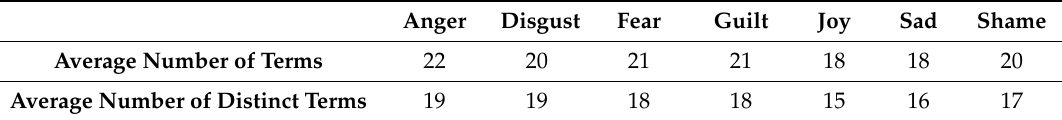
Table 3. Average number of terms and distinct terms per document in ISEAR.